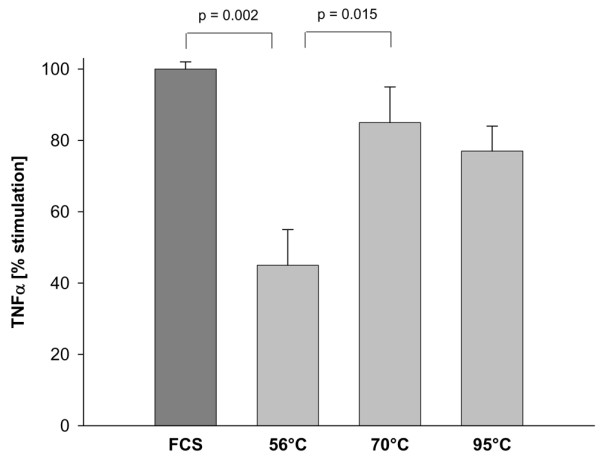
Inhibitory activity of rheumatoid arthritis (RA) sera is not heat stable. Six sera from patients with RA, which previously were found to strongly inhibit T cell-dependent monocyte activation were incubated at 56°C for 30 min, at 70°C for 10 min or at 95°C for 2 min. Co-culture experiments were performed in the presence of 10% FCS or 10% RA sera. All data are expressed as percentages of tumour necrosis factor-α produced in the co-culture system containing 10% FCS. Data are means ± SEM from six independent experiments. P = 0.002 (significant difference from the 100% values).